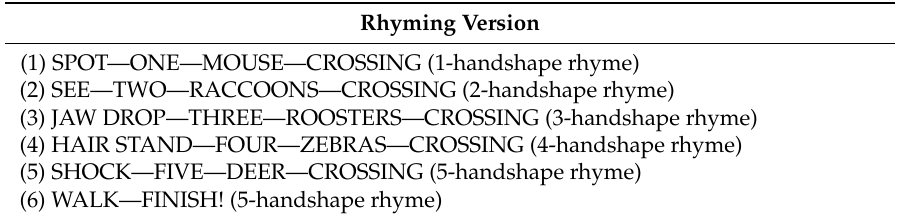
Table 2. Rhyming Version of Animals Crossing.